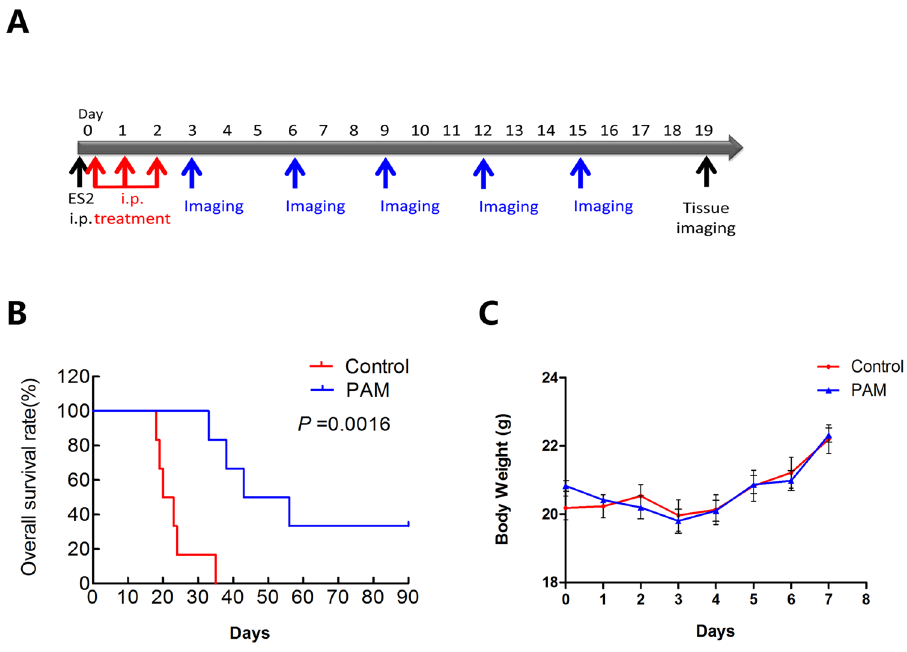
Figure 7. Plasma-activated medium (PAM) treatment prolongs longevity in an ovarian cancer mouse model. ( A ) The treatment and investigation manual of PAM therapy (intraperitoneal) in vivo . ( B ) Survival analysis of mice using the Kaplan–Meier method in the PAM therapy and control groups (n = 6). The analysis considers a total of 90 days. ( C ) Body weight comparison between each group of